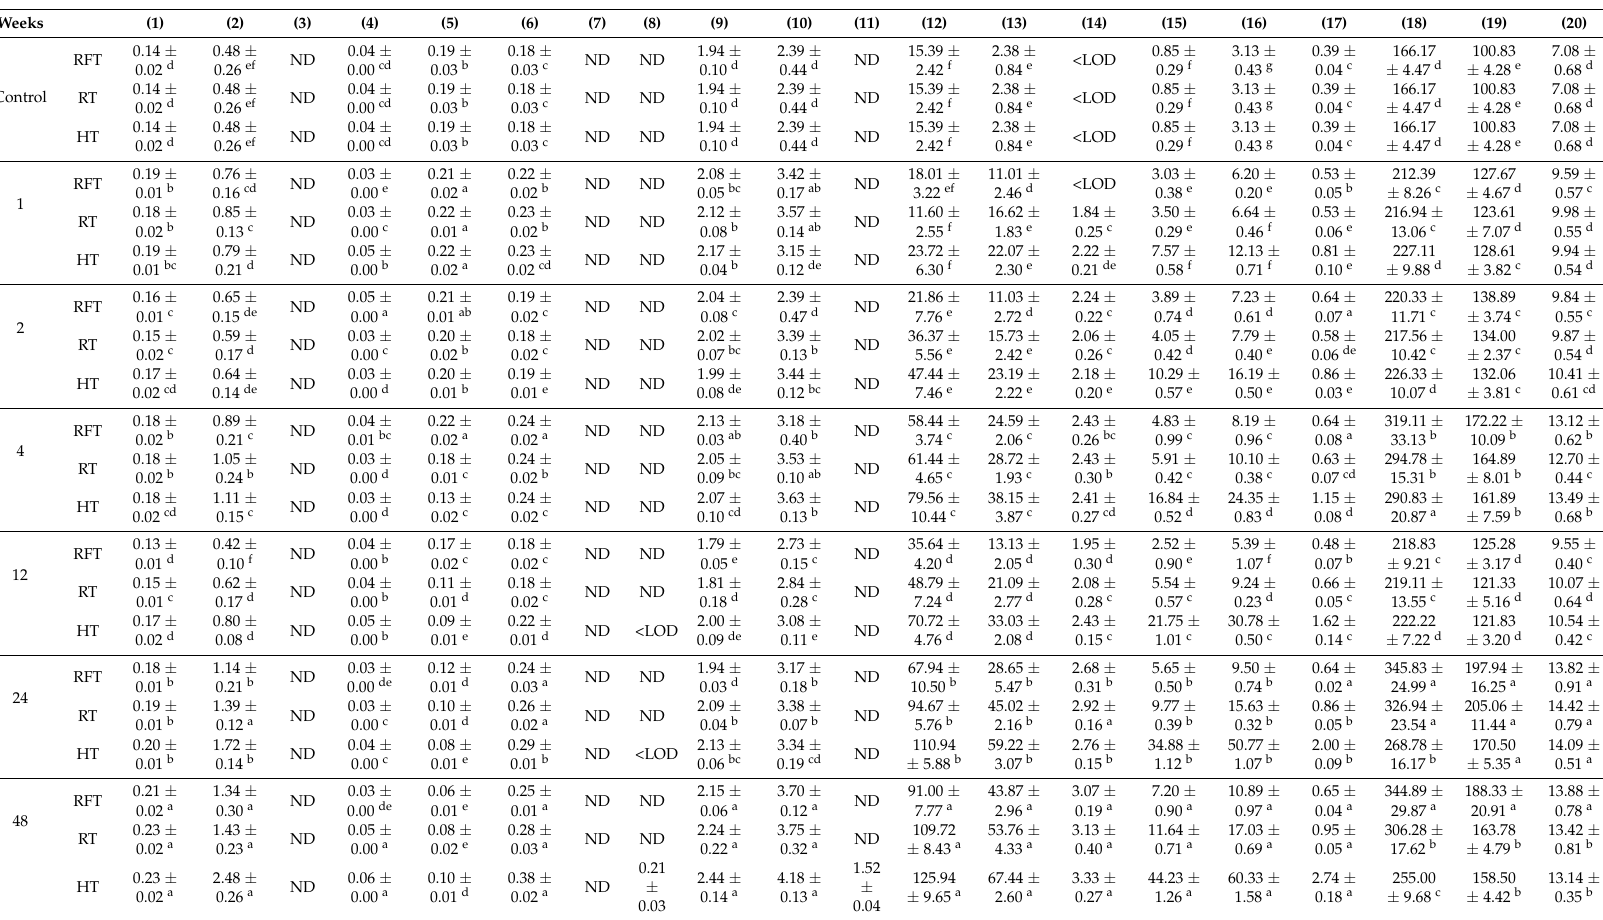
Table 1. Change of composition and content of phenolic compounds (PC) in raw soybean flour (RWSF) stored at 4, 20, and 45 ◦ C ( µ g/g on dry weight